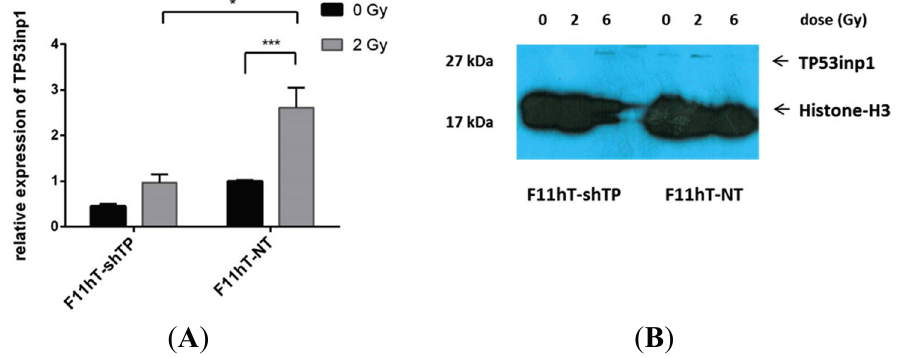
Figure 2. TP53inp1 gene silencing in F11hT-NT and F11hT-shTP cells. ( A ) Values were calculated by qPCR with the ΔΔ CT method. Data are given from at least four experiments, and error bars show SEM of the mean. Gene expression in the F11hT-shTP cells is compared with the sham-irradiated F11ht-NT cells, where the expression is fixed as a level of one.